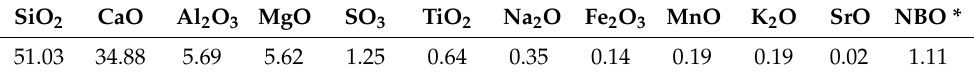
Table 4. Chemical composition of pristine slag (mol%).